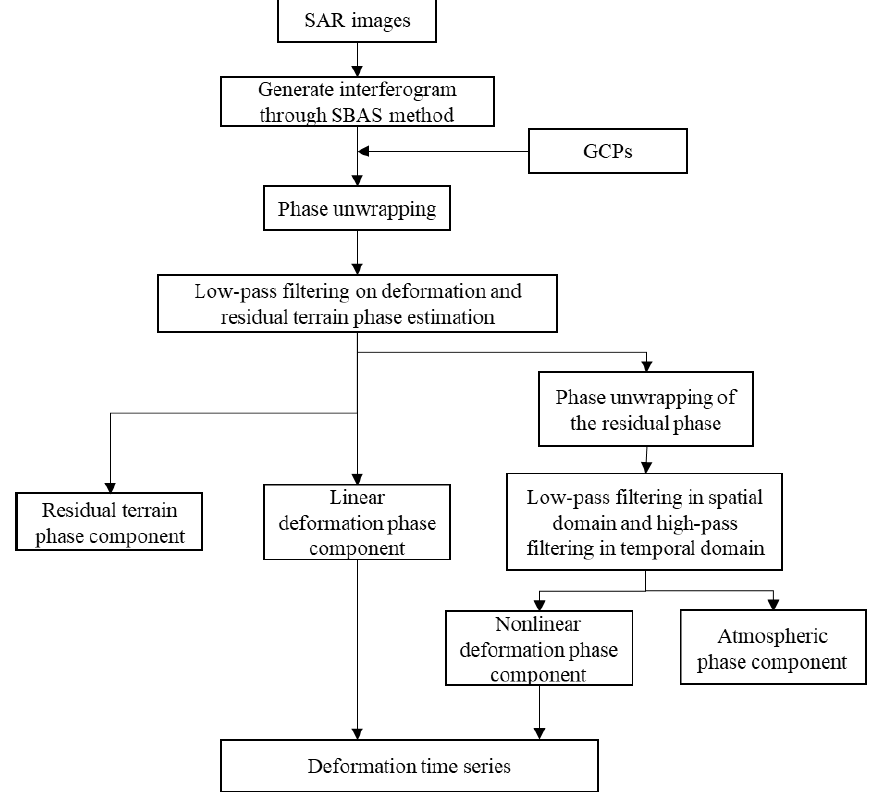
Figure 11. Flow chart of small baseline subsets (SBAS) interferometric synthetic aperture radar (InSAR) modified from Berardino et al. [61] .